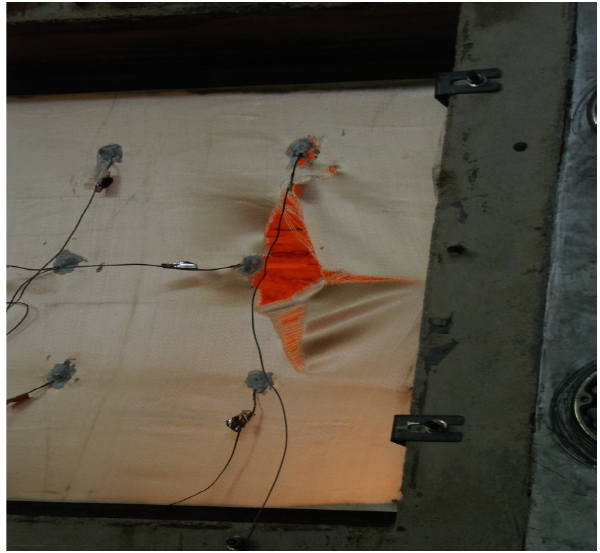
Figure 8. The breakdown of the fireproof curtain without a water film.